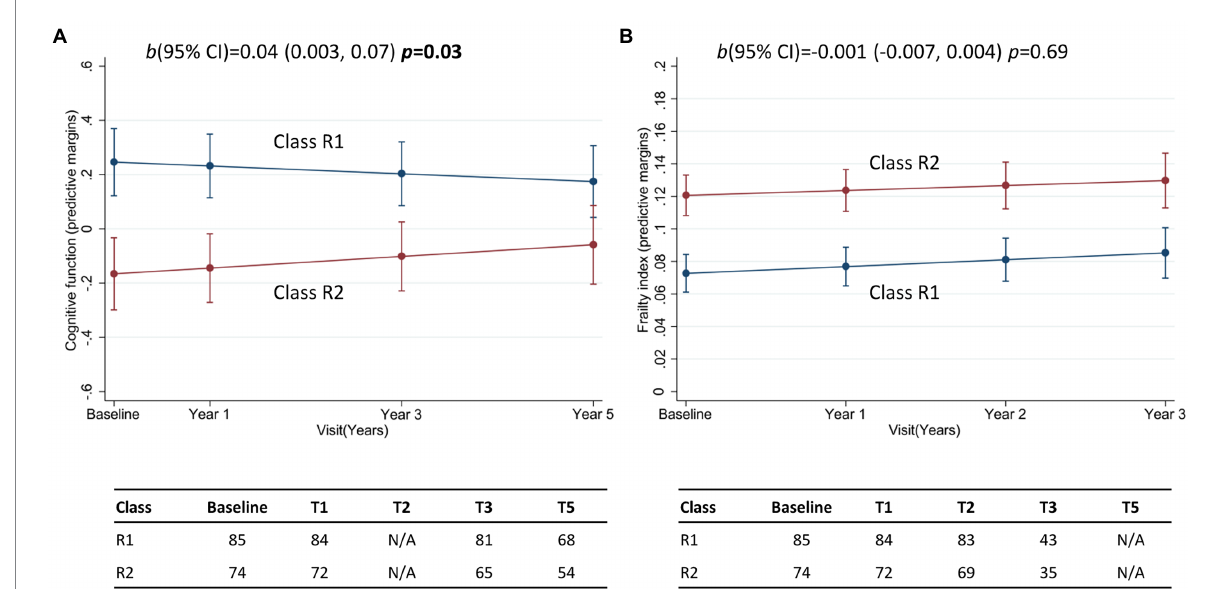
FIGURE 4 Margin plots presenting the two-way interaction between subclasses of the resilient brain age group and the longitudinal change in (A) composite cognitive function, and (B) frailty index. Tables report the frequency of participants who provide data at baseline, and at follow-up assessments. b(95% CI) = unstandardized beta-coefficient of the two-way interaction between class membership and time, and the corresponding 95% confidence interval.